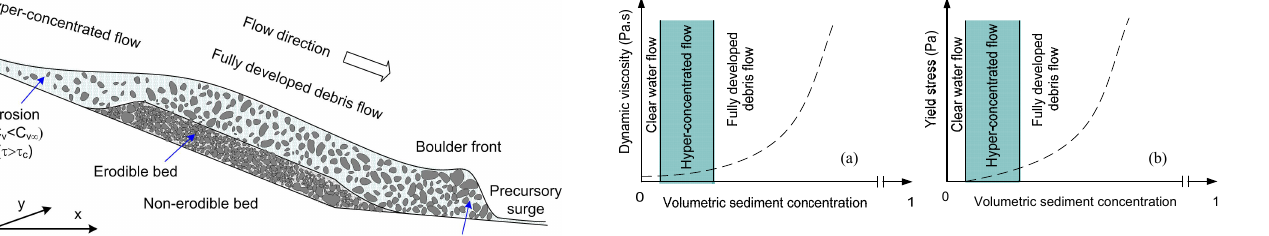
Figure 3. Changes in dynamic viscosity and yield stress with vol- umetric sediment concentration: (a) dynamic viscosity, (b) yield